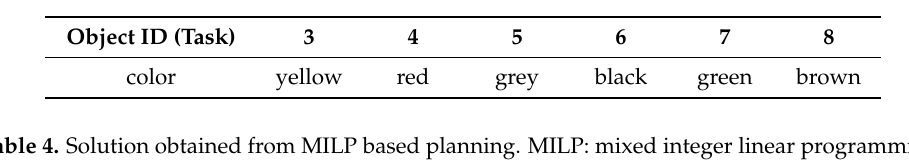
Table 3. Relationship between object ID and color.